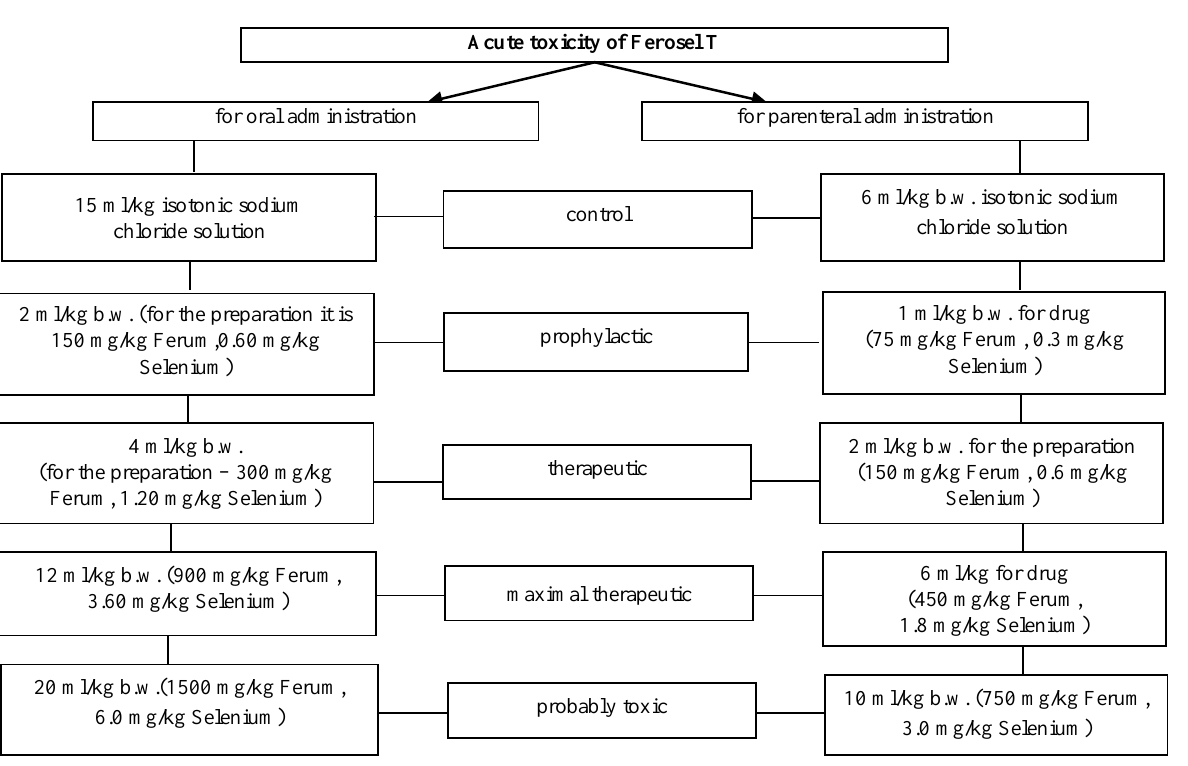
Indicators of the preparation "Ferosel T" toxicity at the administration to stomach of white rats Group of Amount of animals in a Preparation dose, ml/kg animals group